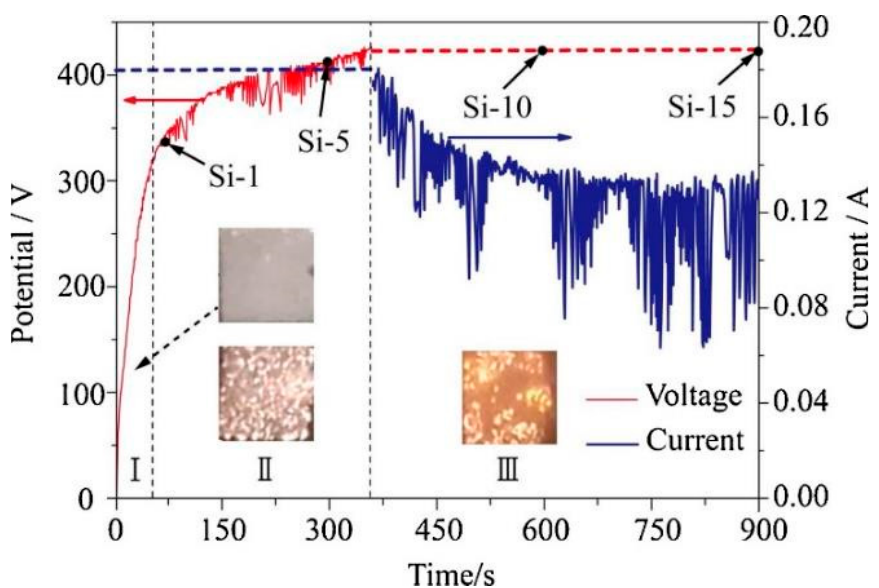
Figure 1. Voltage and current vs. time plots and evolution of discharge sparks. Reprinted from [11] with permission from Elsevier.